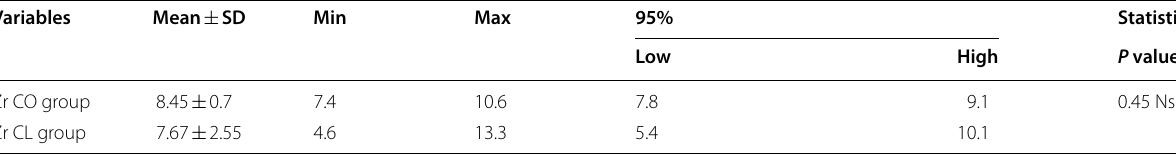
Ns: Non-significant ( p > 0.05)